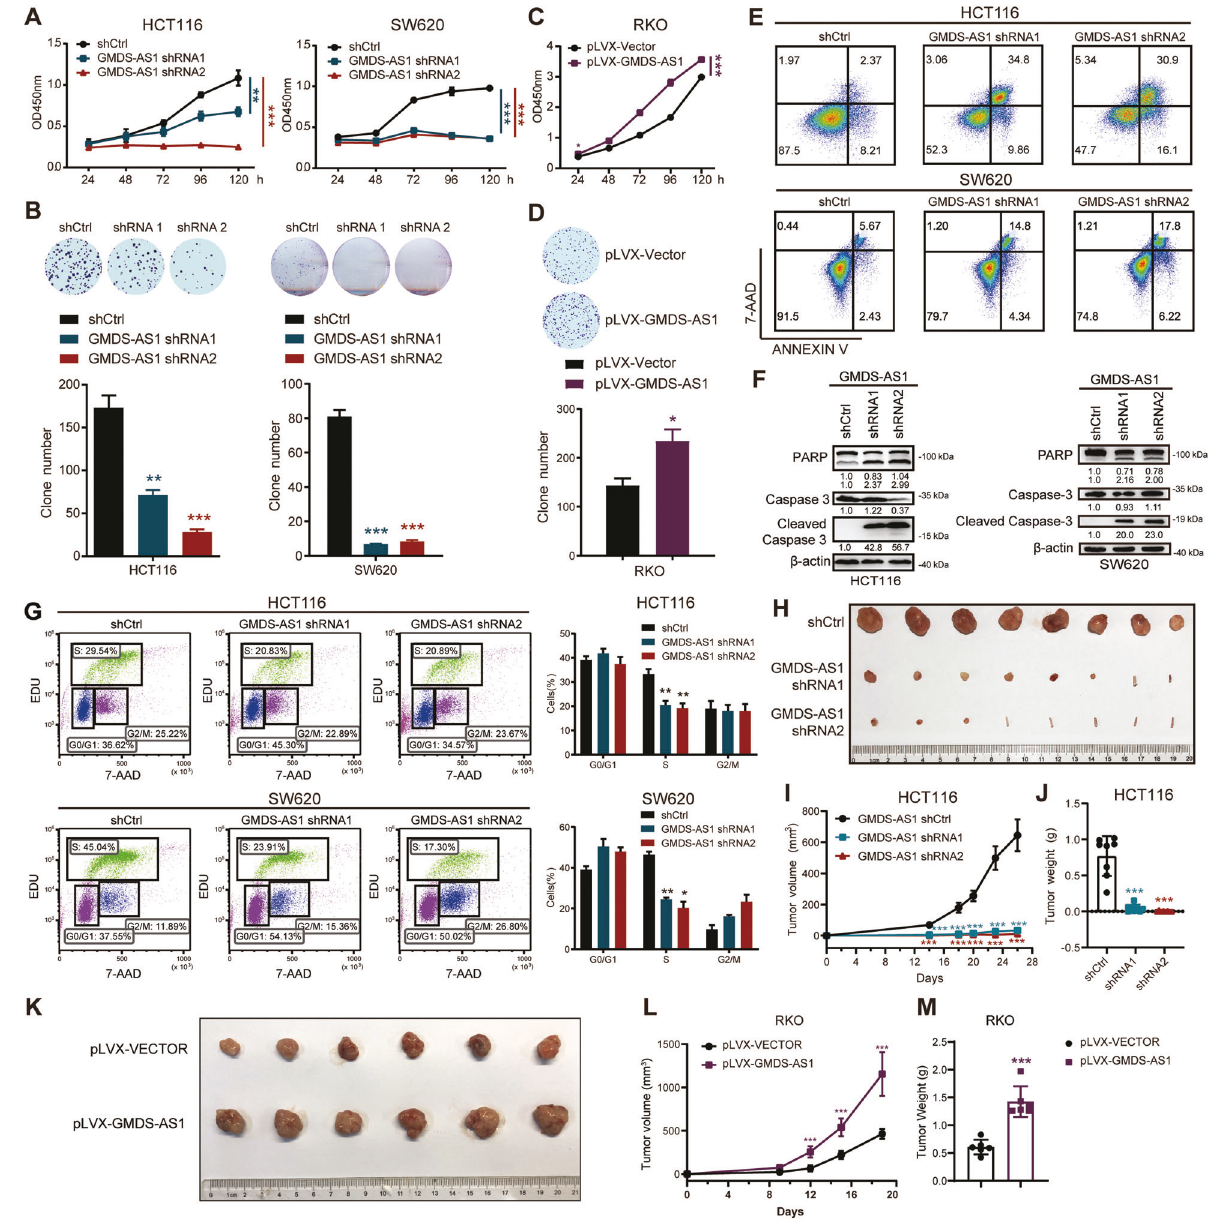
Fig. 2 GMDS-AS1 promotes CRC cell proliferation and inhibits CRC cell apoptosis in vitro and in vivo. A Cell viability was determined by CCK-8 assay with HCT116 and SW620 cells stably transduced with control shRNA (shCtrl) or GMDS-AS1 shRNAs (shRNA1 or shRNA2). B Colony formation assays with HCT116 and SW620 cells stably transduced with control shRNA or GMDS-AS1 shRNAs. Above, representative images; below, quanti fi cation. C CCK-8 assays of control and stable GMDS-AS1-expressing RKO cells. D Colony formation assays with control and stable GMDS-AS1-expressing RKO cells. Above, representative images; below, quanti fi cation. E The percentage of apoptotic HCT116 and SW620 cells was estimated by fl ow cytometry using APC-labeled Annexin V and 7-AAD staining. Representative result based on three independent experiments. F Immunoblot analysis of the apoptosis hallmarks cleaved PARP and Caspase-3 in HCT116 and SW620 cells stably transduced with a control shRNA or GMDS-AS1 shRNA. G Cell cycle evaluation of HCT116 and SW620 cells stably transduced with control shRNA or GMDS- AS1 shRNA by EdU/7-AAD double-staining with fl ow cytometry. Left: fl ow plots. Right: quanti fi cation. H Representative image of xenograft tumors excised from nude mice subcutaneously injected with control or GMDS-AS1 KD HCT116 cells ( n = 8). The small pieces of mouse tails represent the mice that failed to form tumors. I , J Tumor volume and tumor weight of the mice shown in H were measured. K Representative image of xenograft tumors excised from nude mice subcutaneously injected with control or GMDS-AS1 OE RKO cells ( n = 6). L , M Tumor volume and tumor weight of the mice shown in K were measured. A – D Values are expressed as the means ± SEM, n = 3. *** p < 0.001, ** p < 0.01, * p < 0.05 by two-tailed Student ’ s t test. GMDS-AS1 directly binds to HuR protein were highly correlated with the lncRNA GMDS-AS1 expression levels Normally, RNA – RNA interactions and subsequent RNA lifetime (Figs. 4G and S6E). In summary, we found that GMDS-AS1 activated regulation are fi rmly orchestrated by multiple RNA-binding proteins the Jak-STAT3 signaling pathway by stabilizing STAT3 mRNA and then (RBPs) [28]. We performed a biotinylated RNA pull-down assay promoting STAT3 protein expression.